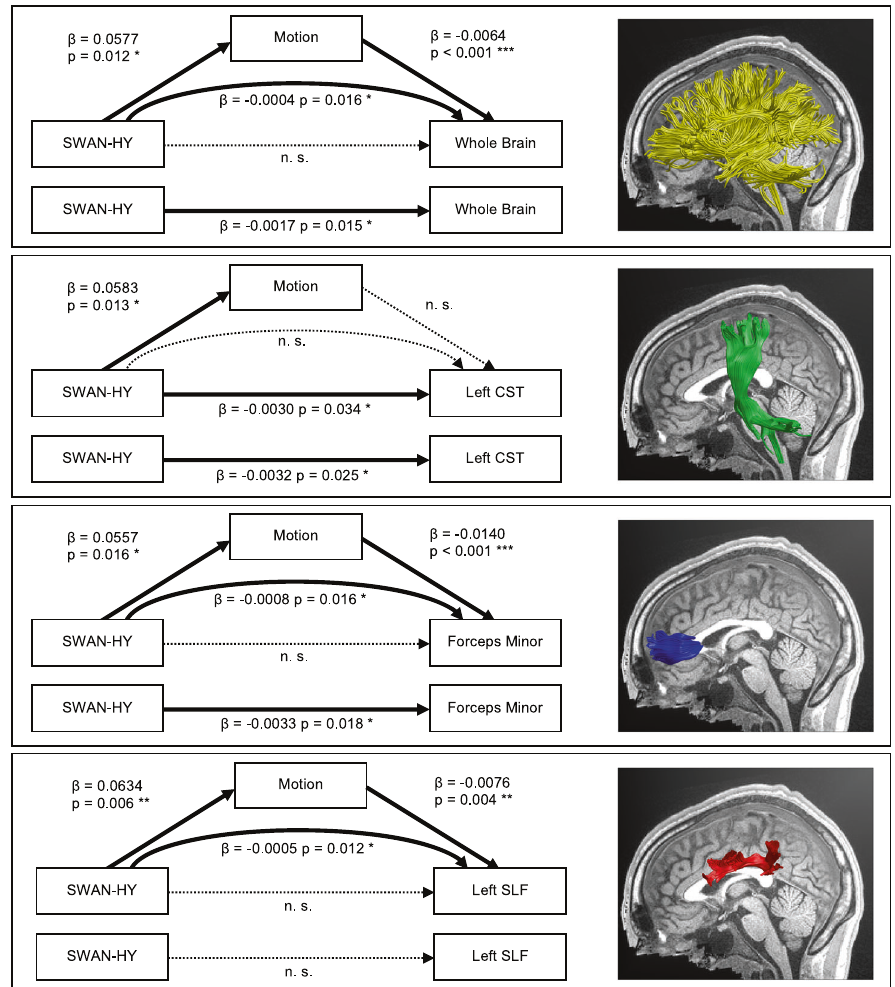
Fig. 4 Results of causal mediation analysis with signi fi cant effects. SWAN-HY, Strengths and Weaknesses Assessment of Normal Behavior Rating Scale for ADHD Hyperactivity Score; CST, corticospinal tract; SLF, superior longitudinal fasciculus; T1-weighted image: X = −